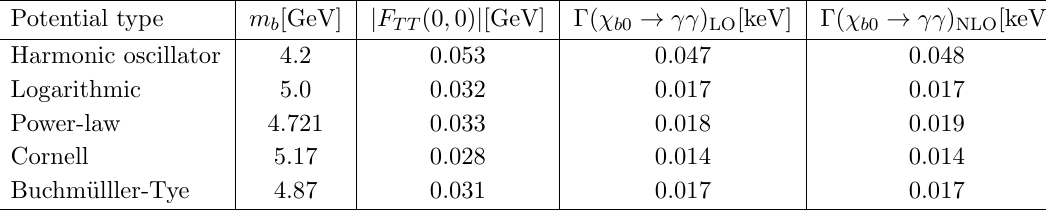
Table 4 . j F TT (0 ; 0) j for (cid:31) b 0 with quark/antiquark mass corresponding to each potential. Here (cid:11) s = 0 : 18 according to ref. [28].